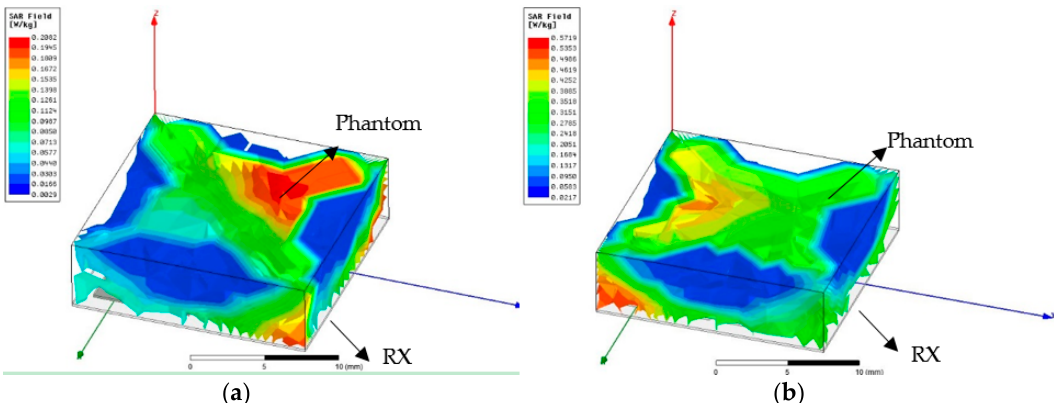
Figure 8. SAR distributions in Phantom (W/kg) ( a ) at 2.5 GHz, and ( b ) at 4.5 GHz.